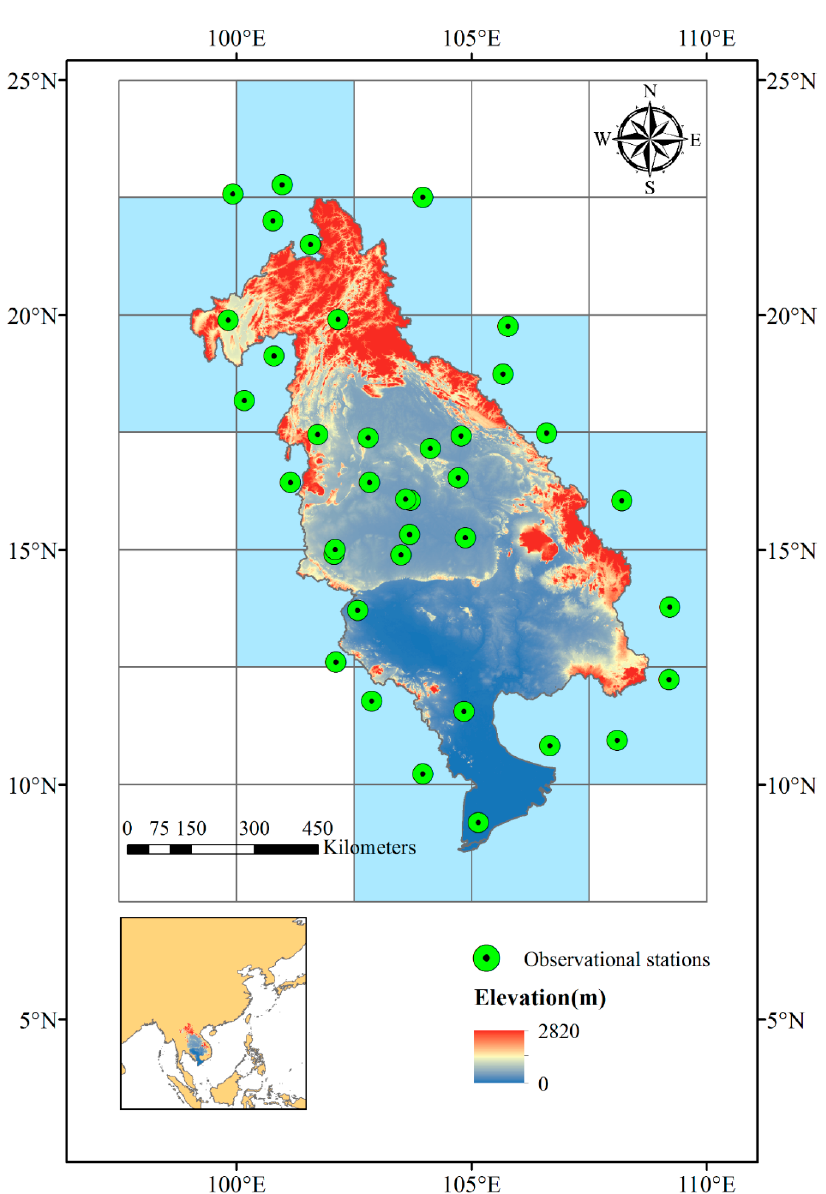
Figure 1. Location of the Lower Mekong Basin (LMB) and observed stations of the Global Surface Summary of the Day (GSOD), the Global Historical Climatology Network (GHCN), and the 21 selected grids over the LMB (shade of blue).